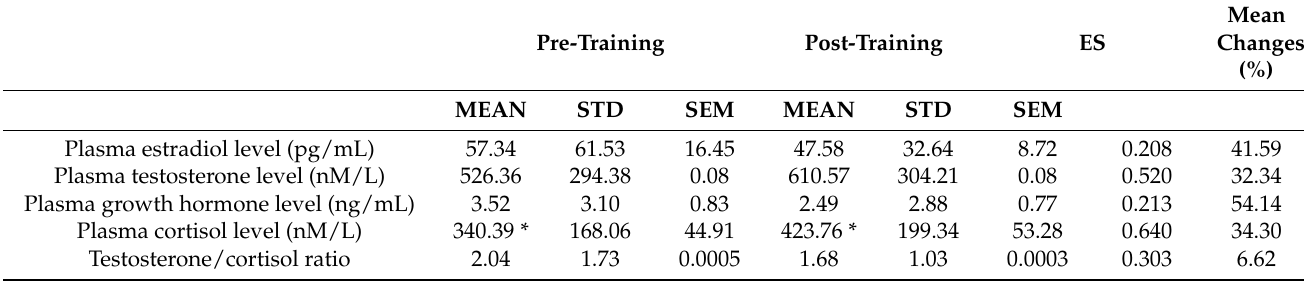
Table 2. Fasting hormonal changes in plasma estradiol, testosterone, growth hormone, and cortisol levels prior to and following the training